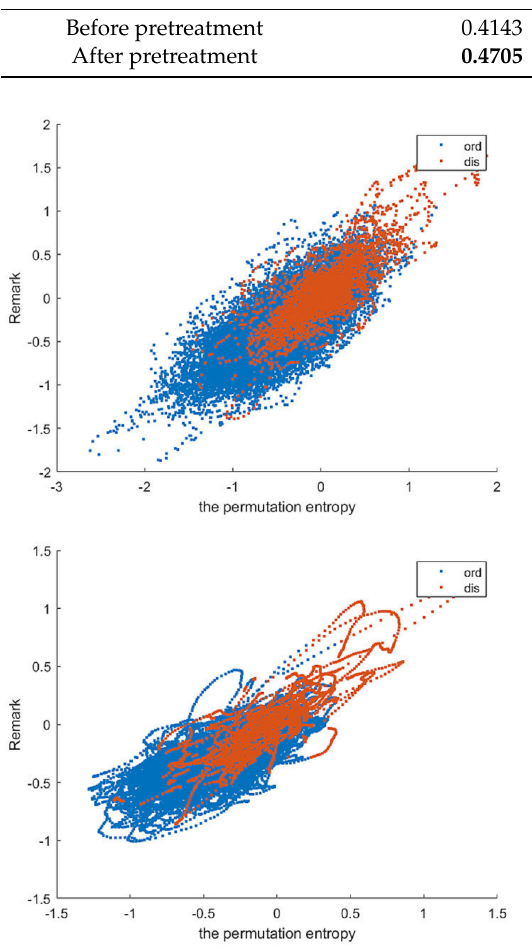
Figure 7. Remark465 and Permutation entropy before and after windowing. In order to test the predictions of the model, we take the IAPP protein associated with type-2 diabetes from DisProt as an example and acquire the prediction result as Figure 8. At the same time, the standard prediction results are shown as Figure